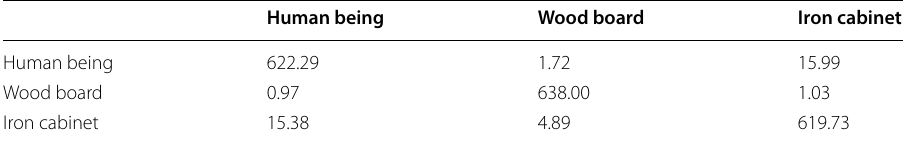
r ( t ) is the target waveform, and the resolution of the scan waveform is 61 ps